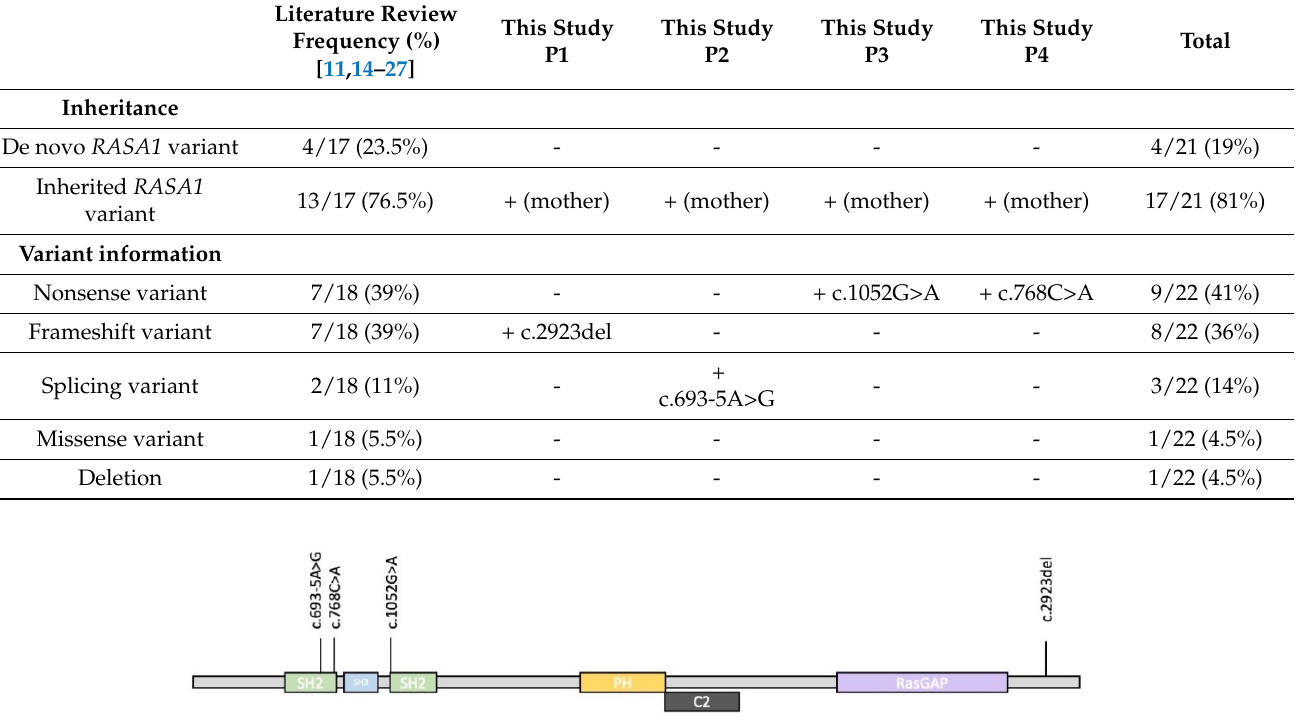
Figure 4. Schematic representation of the localization of variants found in our patients in the RASA1 gene: one splicing variant (c.693-5A>G), two nonsense variants (c.768C>A and c.1052G>A) and one frameshift variant